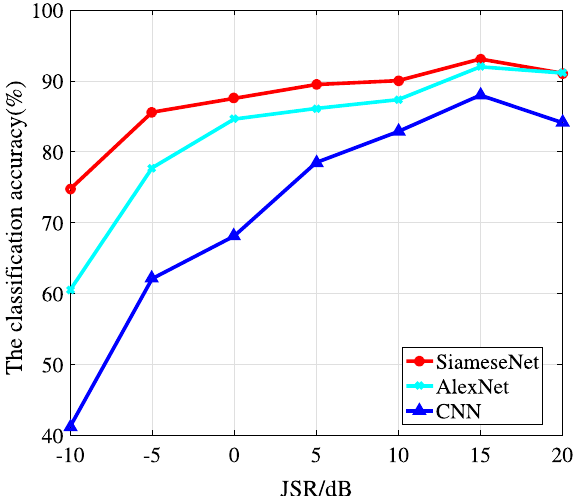
Fig. 10 Classification accuracy of different neural network versus